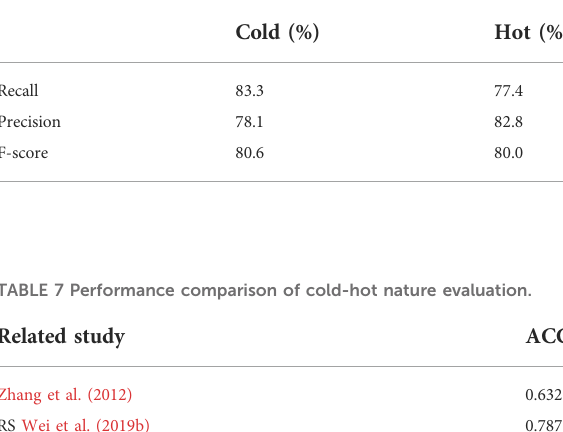
TABLE 6 The recall, precision and F-score of 61 CHMs.